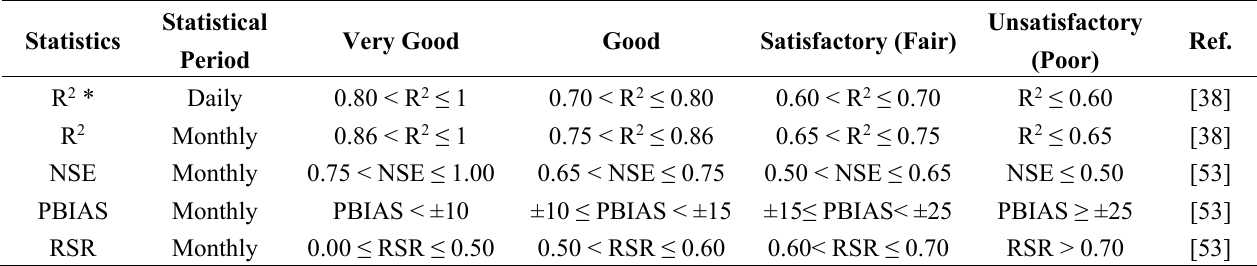
Table 4. General guidance for performance assessment of hydrologic